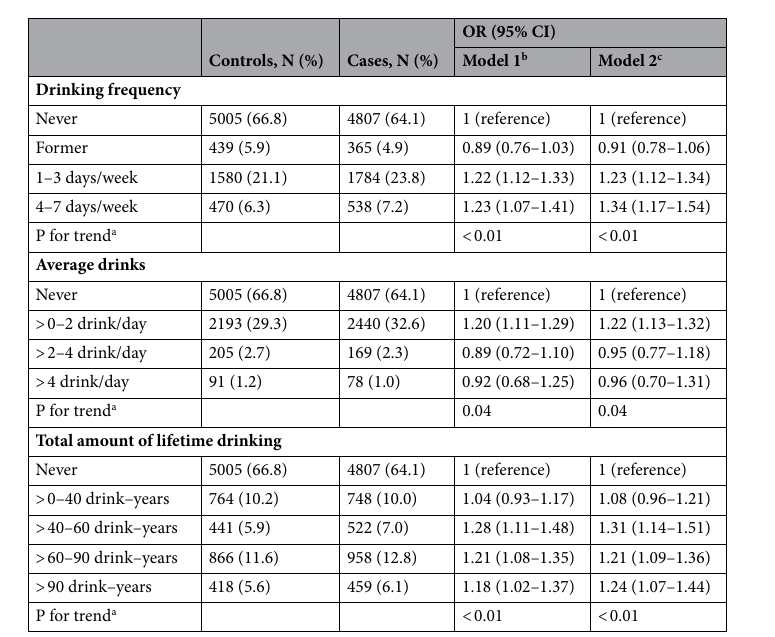
Table 4. Odds ratios for incident cataract surgery estimated with the categorical alcohol use patterns (women). OR odds ratio, CI confidence interval. a Trend test was calculated for the associations between alcohol use patterns as a continuous variable and incident cataract surgery. b Conditional logistic regression matched for sex, age, admission date, and hospital. c Additionally adjusted for smoking history, lifestyle-related comorbidities (hypertension, hyperlipidaemia, diabetes, and obesity), occupational radiation exposure, and outdoor